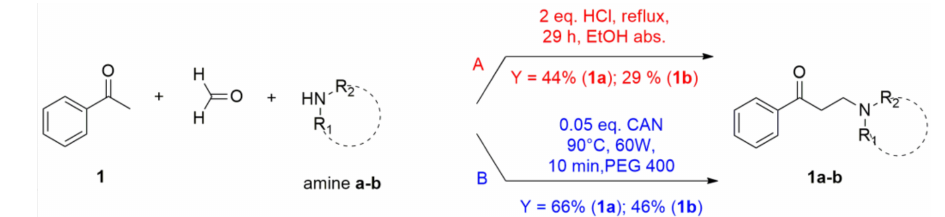
Figure 4. Comparison between (A) traditional and (B) new protocol.